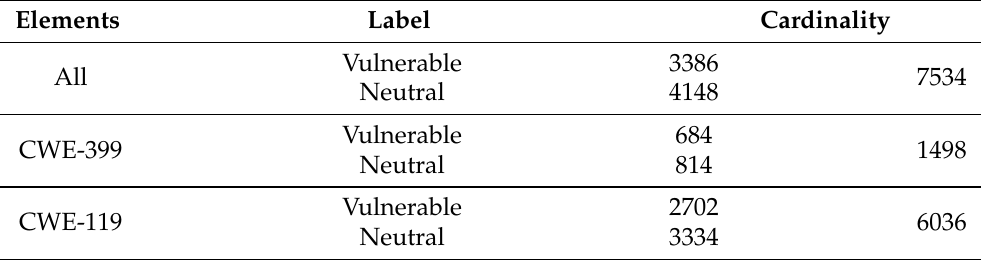
Table 1. The cardinality of the code element sets with information on the class distribution used in the experiments. CWE, Common Weakness